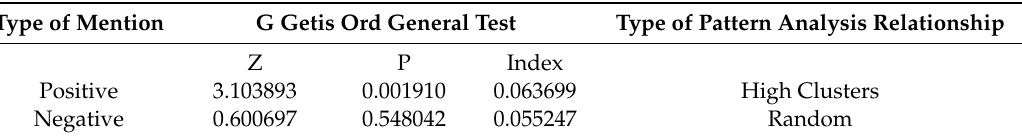
Table 4. G Getis Ord test on Foods and